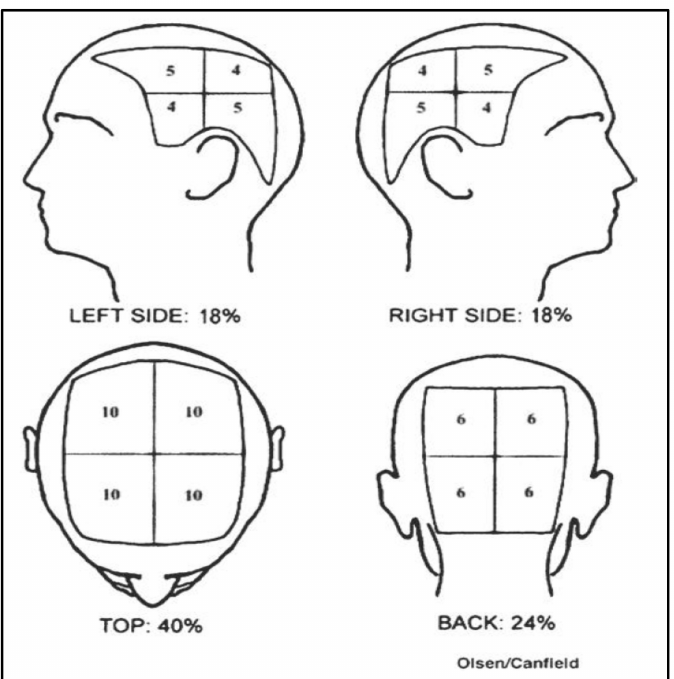
Figure 1. Severity of Alopecia Tool (SALT) score scheme (adapted from reference